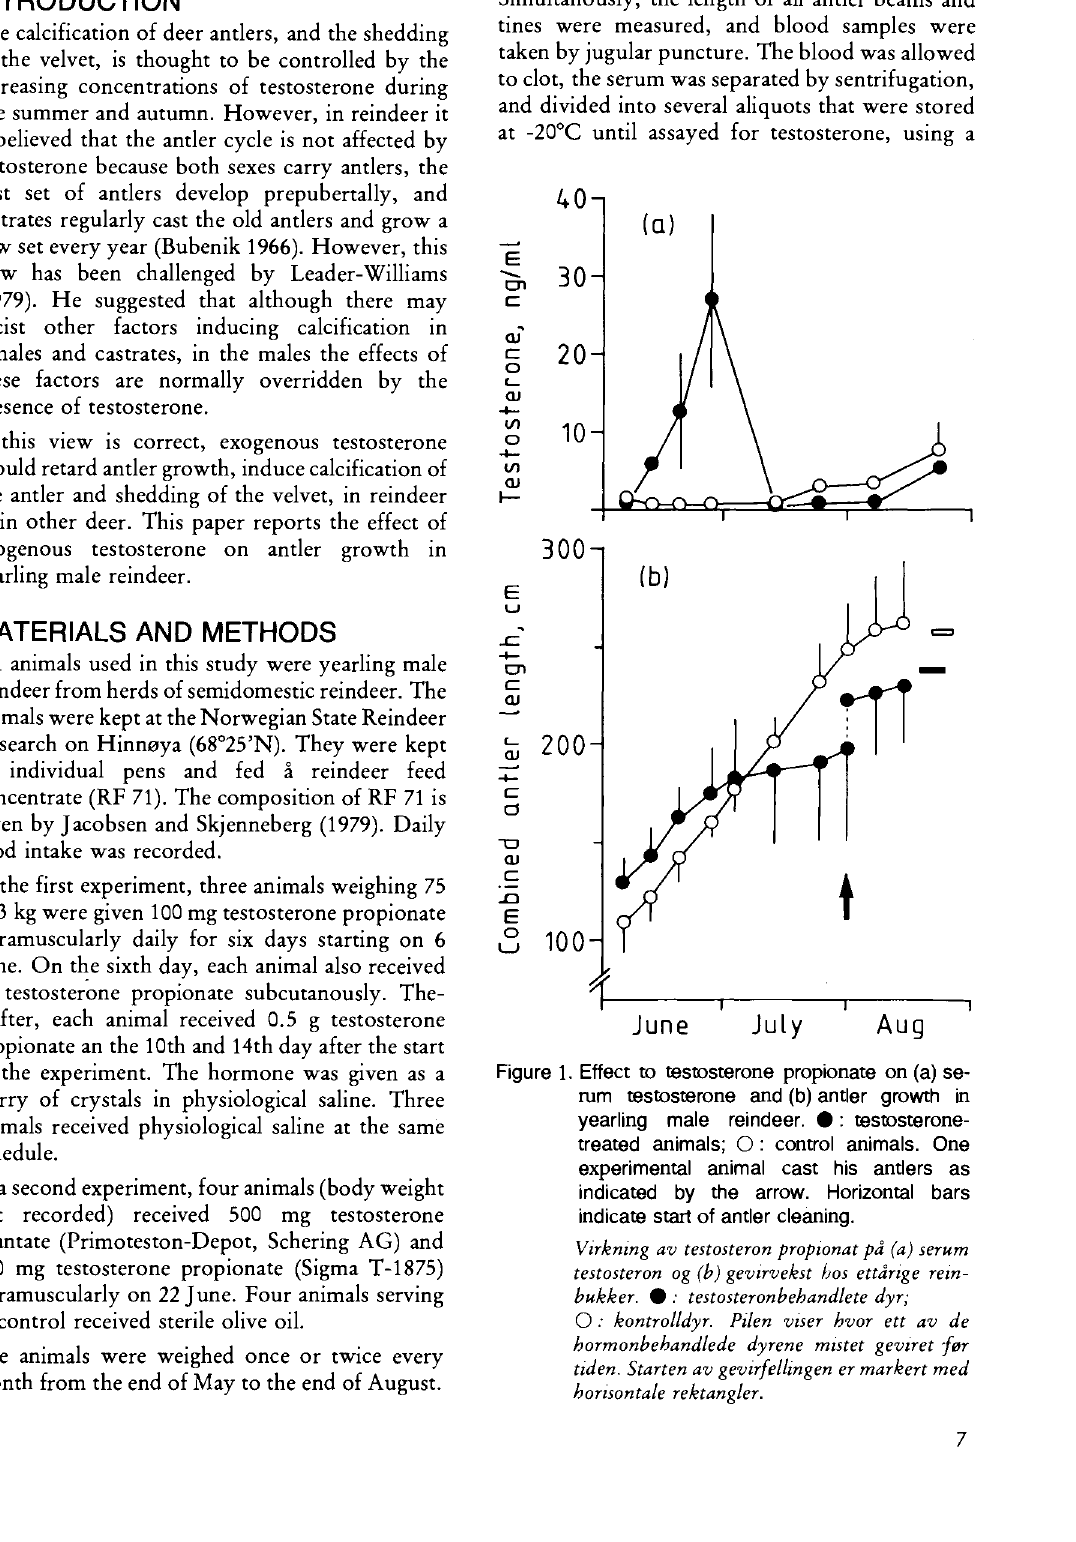
Figure 1 . Effect to testosterone propionate on (a) se rum testosterone and (b) antler growth in yearling male reindeer. •: testosterone- treated animals; O : control animals. One experimental animal cast his antlers as indicated by the arrow. Horizontal bars indicate start of antler